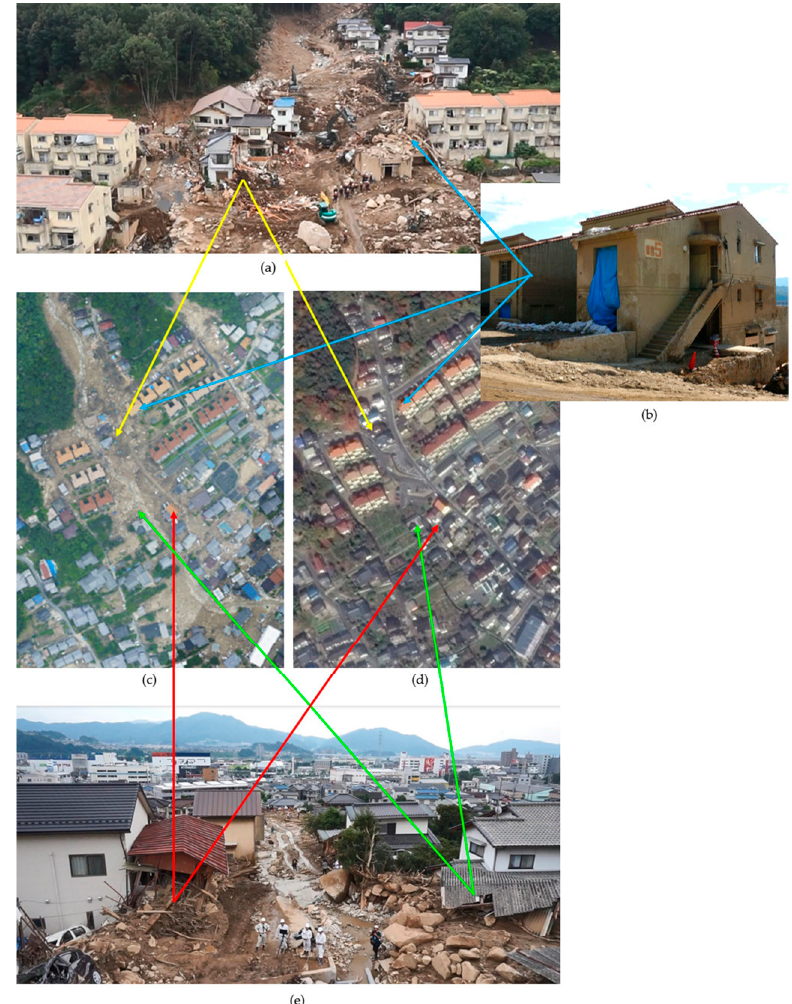
Figure 11. Damaged houses in the residential area, Asaminami, Hiroshima. ( a ) and ( e ), which were taken by Luce Search Inc., show damaged houses. ( b ) shows reinforced concrete buildings with small damages. ( c ), which was taken by Japanese Ministry of Land, Infrastructure, Transport and Tourism, is an aerial image after the disaster. ( d ), which is from Google Earth, is an aerial image before the disaster.